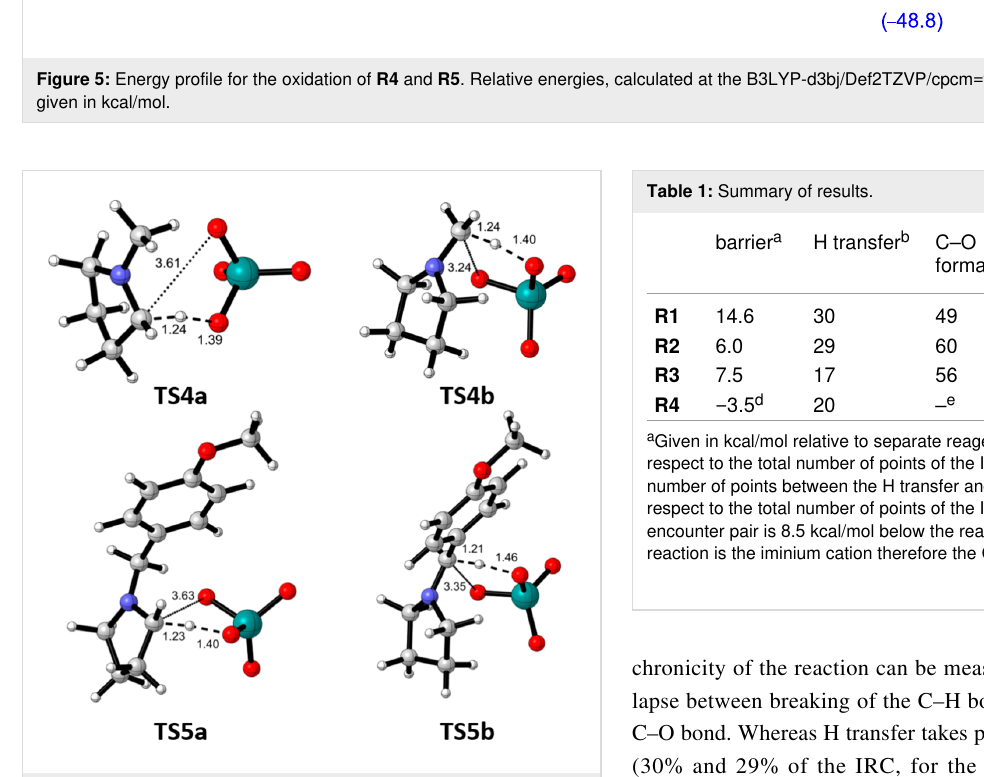
Figure 6: Optimized (B3LYP-d3bj/Def2SVP/cpcm=water) transition structures for the oxidation of R4 and R5 .